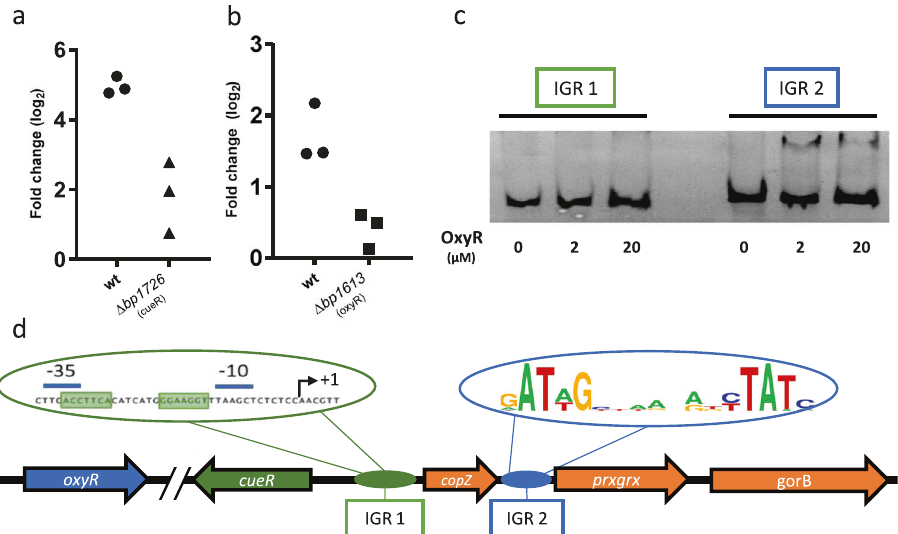
Fig. 6 Regulation of the operon. a , b qRT-PCR analyses of the parental and the cueR KO strains treated for 30 min with 2 mM CuSO 4 ( a ) or 10 mM H 2 O 2 ( b ), showing the expression levels of prxgrx relative to untreated controls. Data were normalized with the housekeeping gene bp3416 . Three biological replicates were performed. ( c ) EMSA with recombinant OxyR and DNA fragments of the cueR-copZ and copZ-prxgrx intergenic regions, IGR 1 and IGR 2, respectively. The uncropped gel is shown in Supplementary Figure S10. ( d ) Schematic representation of the locus, with sequences of the putative CueR and OxyR boxes. The site of transcription initiation was determined by 5 ’ RACE (Supplementary Figure S5). The putative OxyR binding sites were identi fi ed by their similarity with the E. coli consensus sequences, and alignments of the Bordetella and Achromobacter sequences were used to build the consensus motif (Supplementary Figure